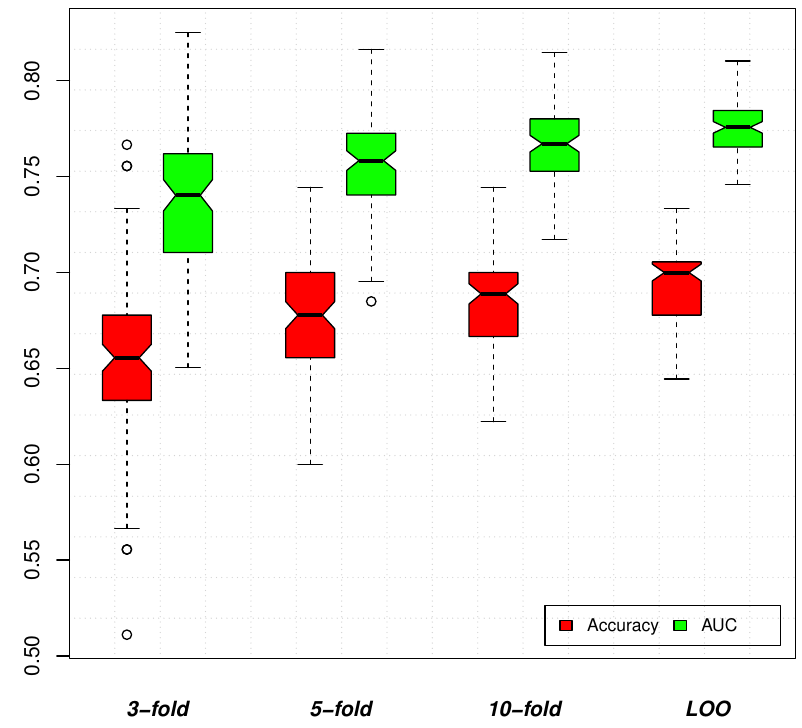
Figure 6. Accuracy and AUC values for different cross validation frameworks. All CV frameworks 100 times have been repeated. Empty bullets represent the outliers of